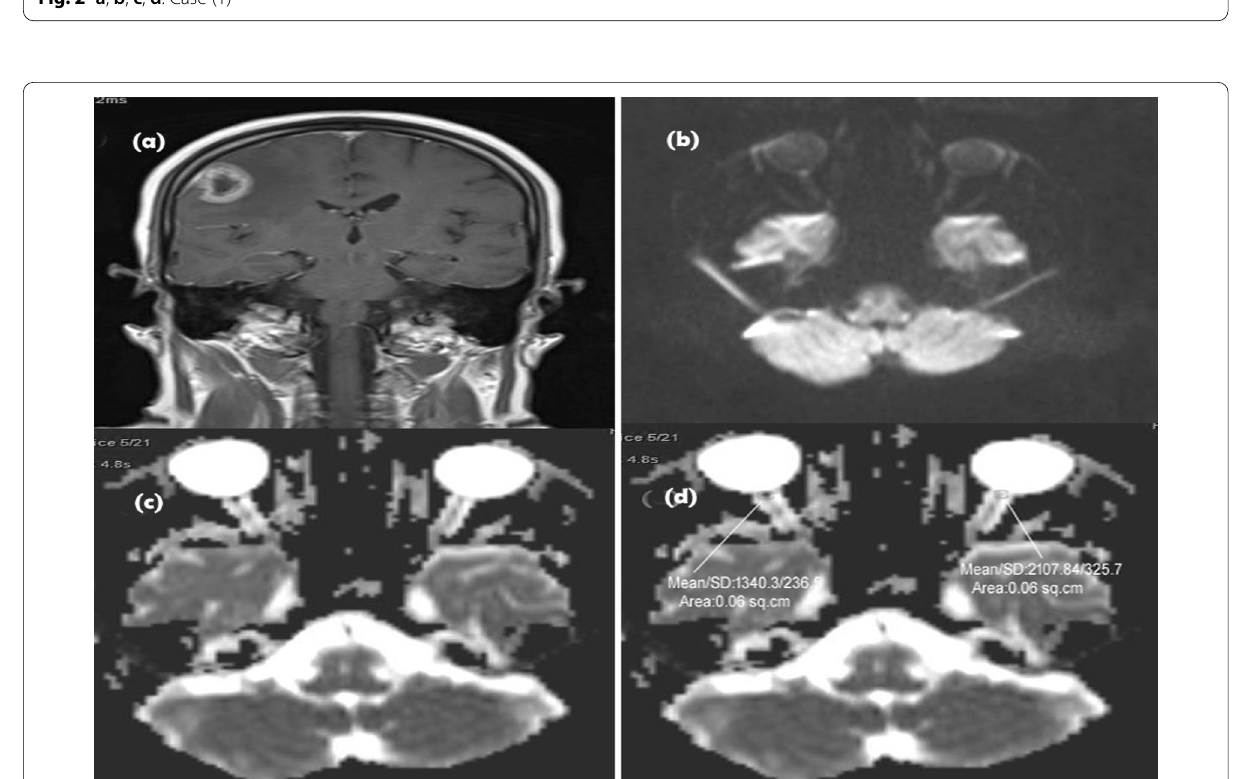
Fig. 3 a , b , c , d : Case